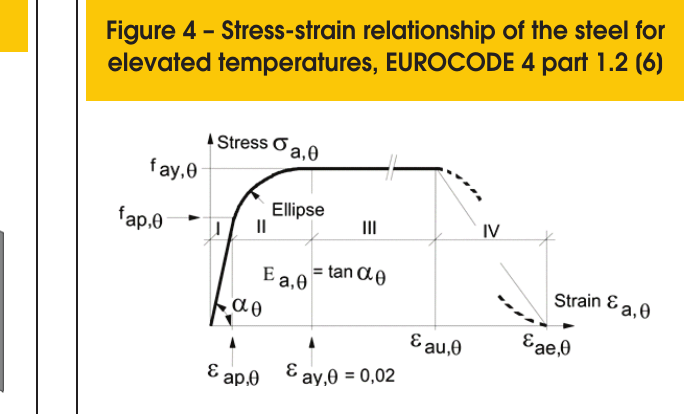
Figure 4 – Stress-strain relationship of the steel for elevated temperatures, EUROCODE 4 part 1.2